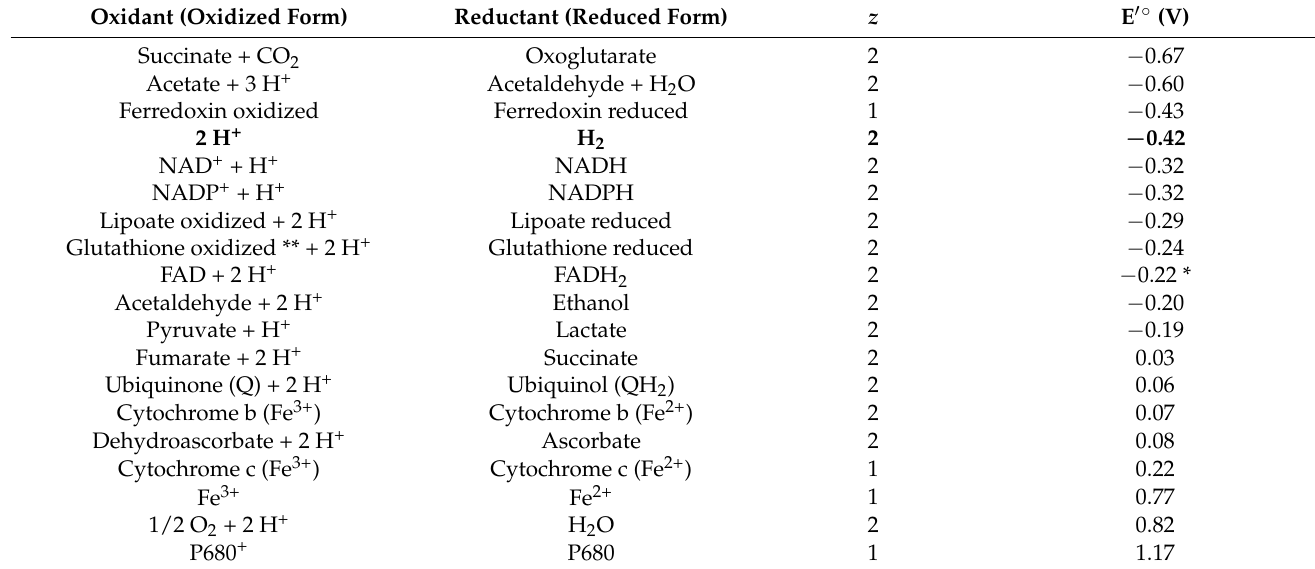
Table 3. Standard reduction potentials of some half-reactions important in